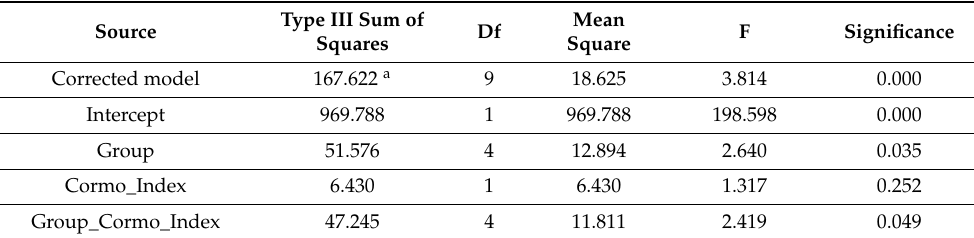
Table 3. Morbidity index influences on GIA.